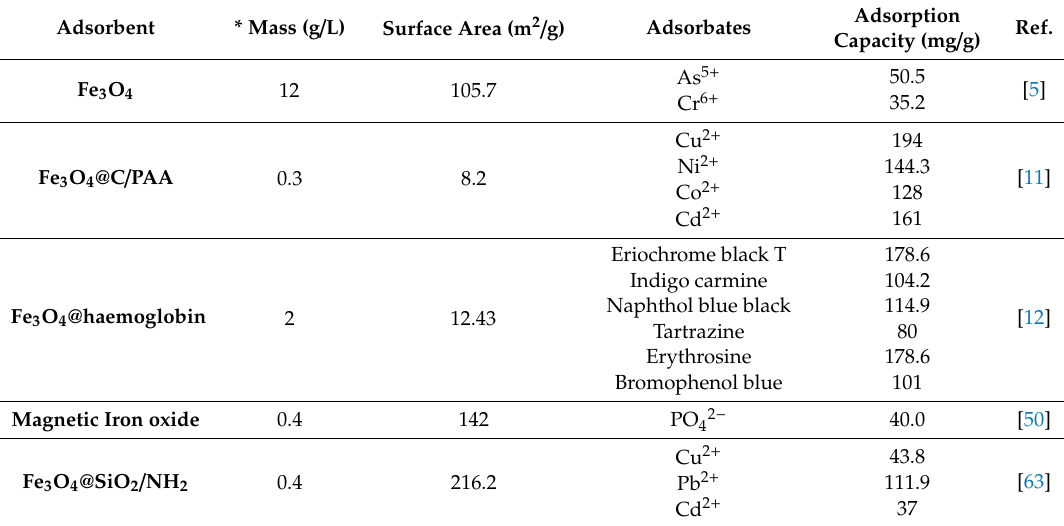
Table 3. Adsorptive properties of selected magnetic nanocomposites for wastewater treatment. Adsorbent